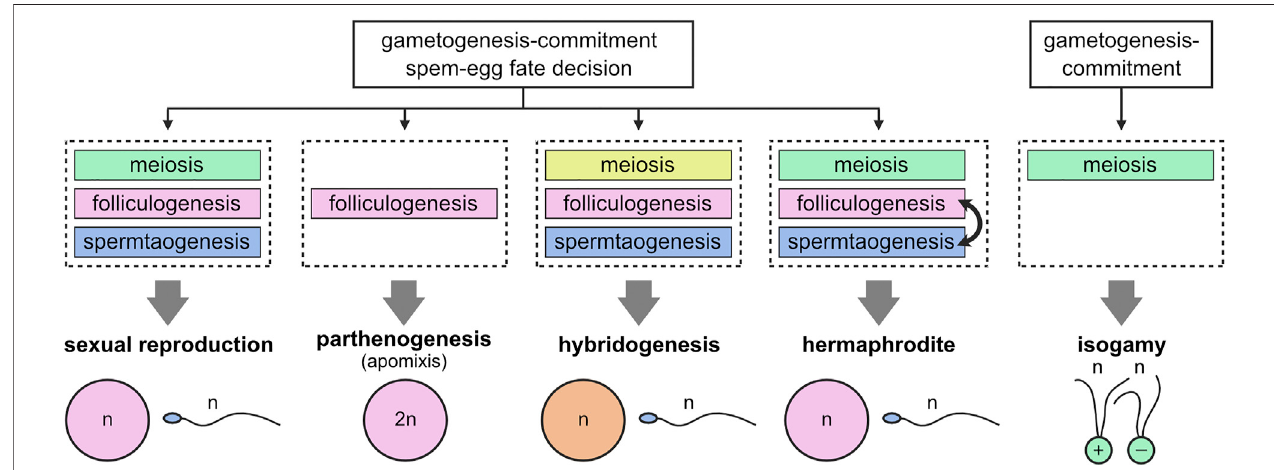
FIGURE 2 | Modular structure of gametogenesis. Initial events of gametogenesis-commitment and sperm-egg fate decision trigger distinct developmental processes,correspondingtodistinctmodules(meiosis,folliculogenesis,andspermatogenesis).Gain,loss,oralterationofmodulesduringevolutioncanexplainadaptive diversi fi cation of reproductive